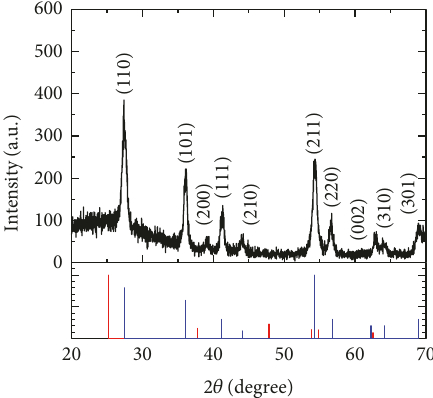
Figure 3: Powder XRD pattern of sintered BR-TiO particles: 33wt%. Blue lines indicate the concentration of TiO 2 database values for rutile TiO (PDF: 00-001-1292) and red for 2 anatase TiO (PDF: 00-021-1272). 2